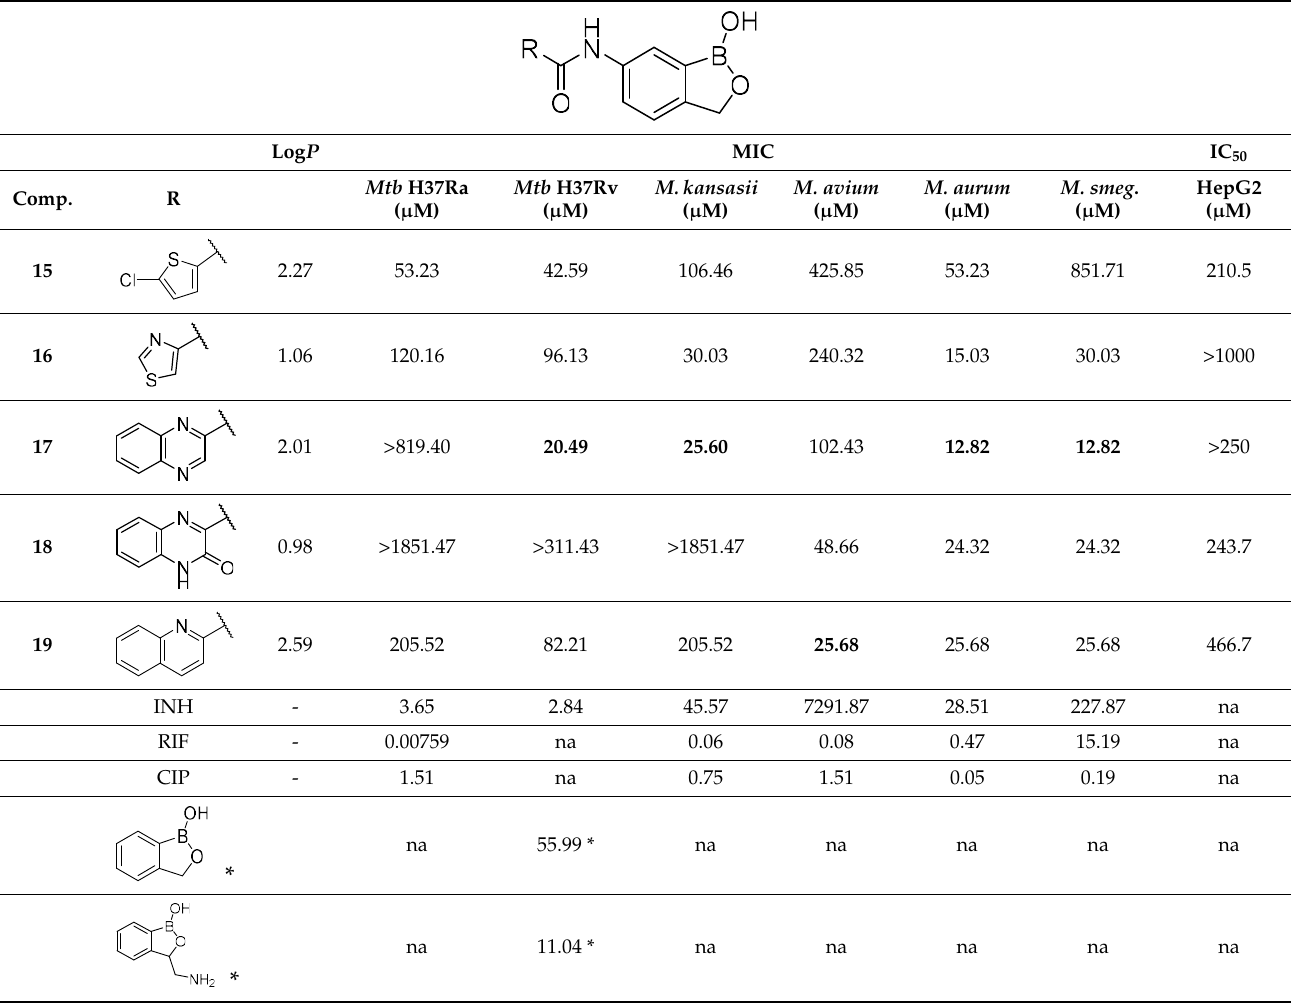
Table 1 . Calculated lipophilicity of the prepared compounds (log P ), comparison of their antimycobacterial activity (MIC) with standards, and their cytotoxicity against HepG2 (IC 50 Table 1. Cont .